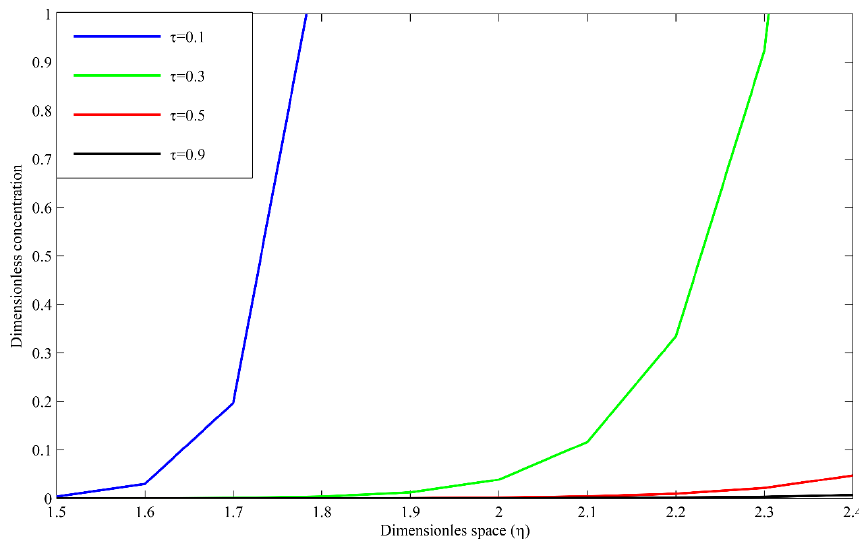
Figure 7. Dimensionless autocatalytic concentration profiles in the coating.